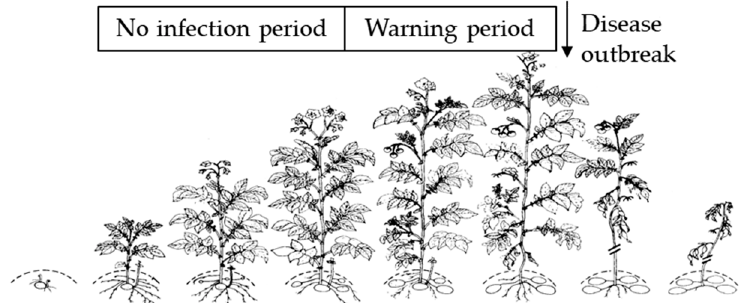
Figure 3. Simplified schematics illustrating the temporal split of the data for the diagnostic performance calculation (source [55]).